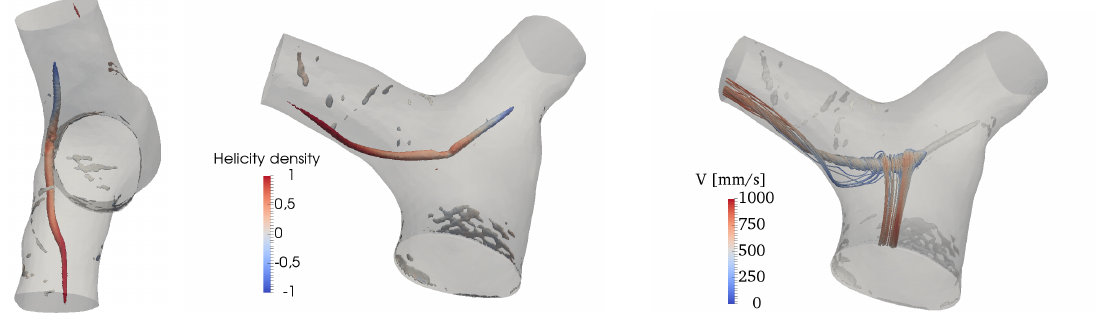
Figure 10. Vortex structures visualized by isosurfaces of Q and colored by normalized helicity at peak systole (left) and deceleration phases.